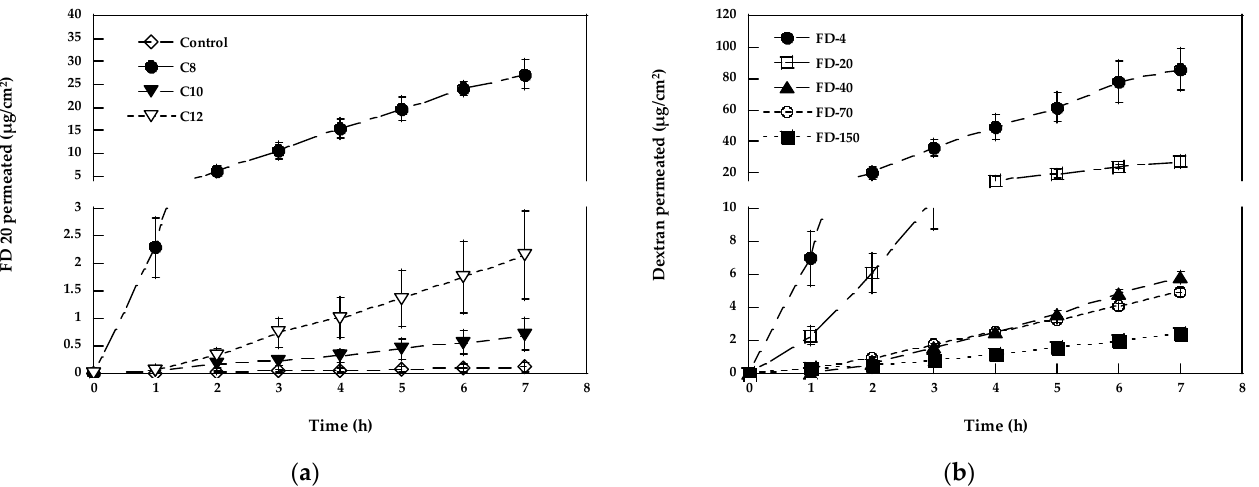
Figure 3. ( a ) Permeation profiles of FD-20 after pre-treatment with different fatty acids; ( b ) permeation profiles of FD-4, FD-20, FD-40, FD-70, and FD-150 after pre-treatment with caprylic acid (C8). Mean values ± SEM.